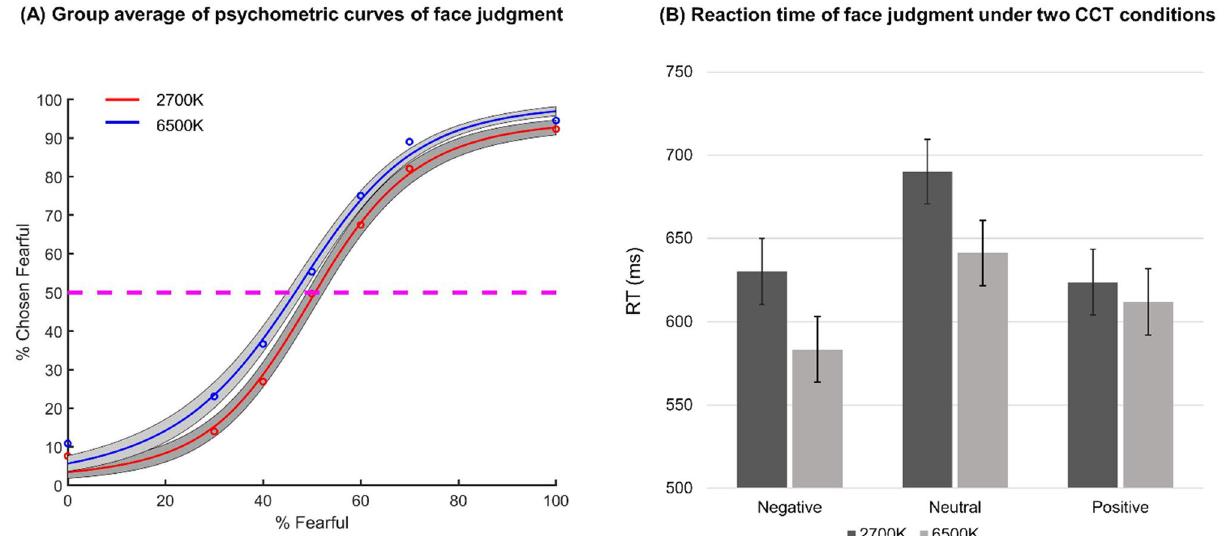
Figure 3. ( A ) Group average of psychometric curves showing the proportion of trials judged as fearful as a function of morph levels (ranging from 0% fearful (100% happy; on the left) to 100% fearful (0% happy; on the right)). Shaded area denotes ± SEM across subjects. ( B ) Face judgment reaction time of negative vs. neutral vs. positive faces under two CCT conditions. Whiskers represent standard